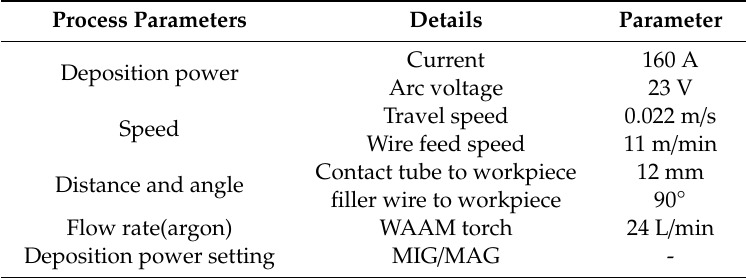
Table 2. Process parameters for WAAM deposition.